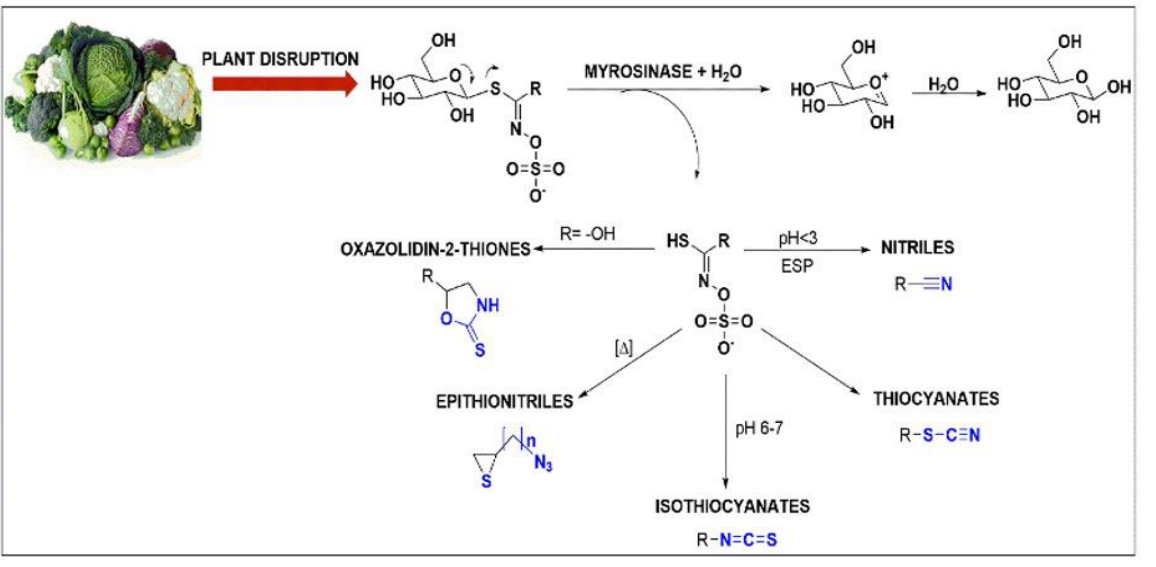
Figure 2. Hydrolysis of GSLs via enzymatic catalysis by myrosinase is activated upon tissue plant disruption. The formed aglucone can be rearranged into oxazolidin-2-thiones, nitriles, epithionitres, thiocyanates, and ITCs.